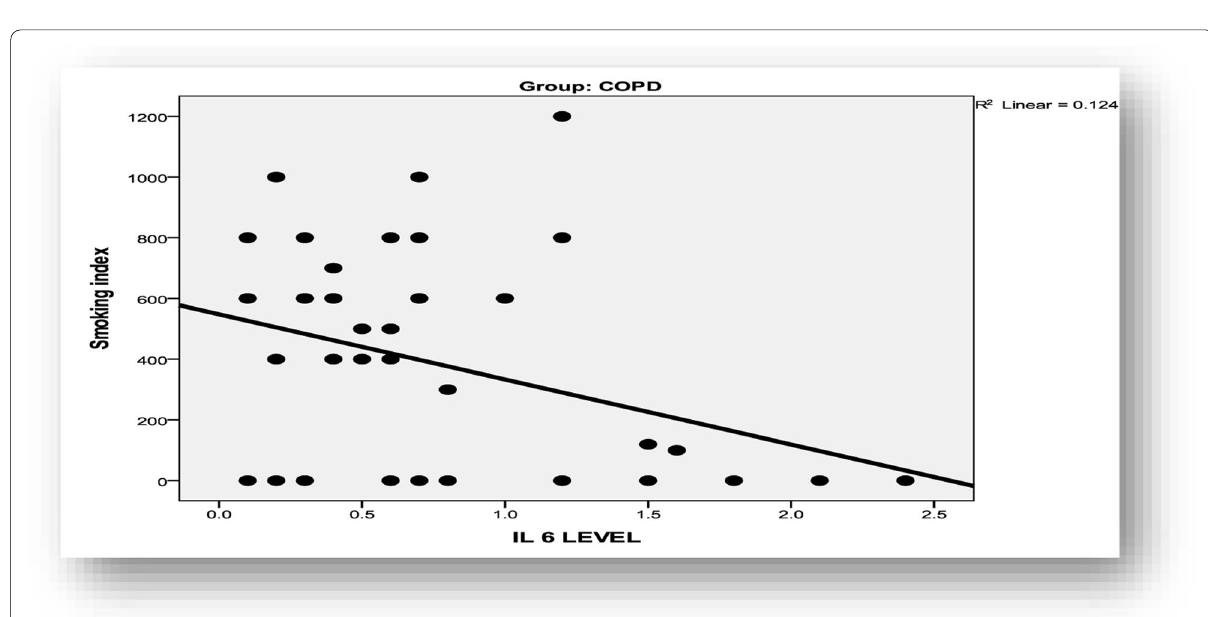
Fig. 1 Correlation between IL‑6 level with smoking index among cases of